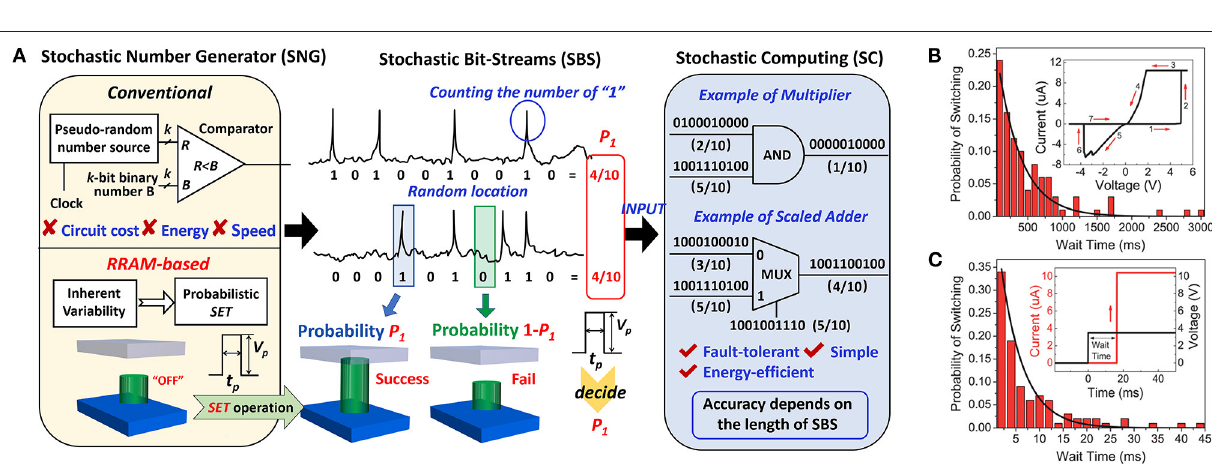
FIGURE 8 | (A) RRAM-based IMP logic operation and the truth table. (B) The subcircuit of the NAND operation by using three RRAM devices with common WL and the corresponding measured results. The logic inputs are stored in devices A and B, while Y stores the output. (C) The subcircuit of one-bit full adder and the corresponding computation procedure. Here “NAND(A, B) → Y” represents that states of devices A and B are executed; the NAND operation and the output are stored into device Y. Reprinted from Borghetti et al. (2010) and Huang P. et al. (2016).